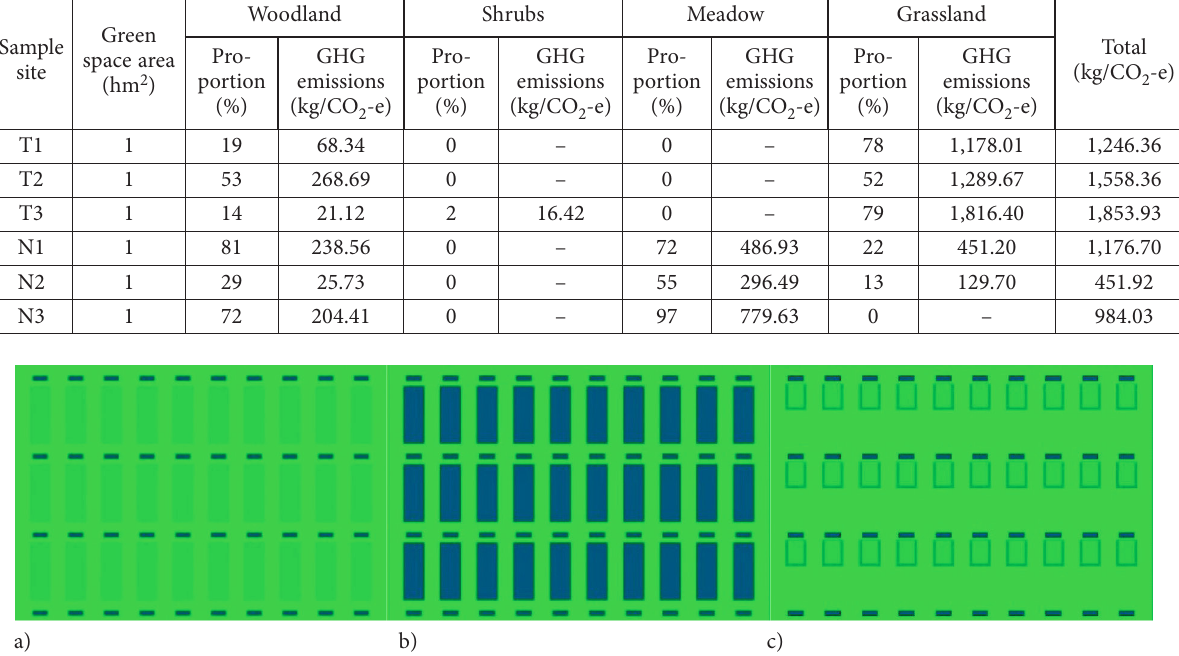
Figure 7. Common memorial facility layouts in a traditional cemetery: